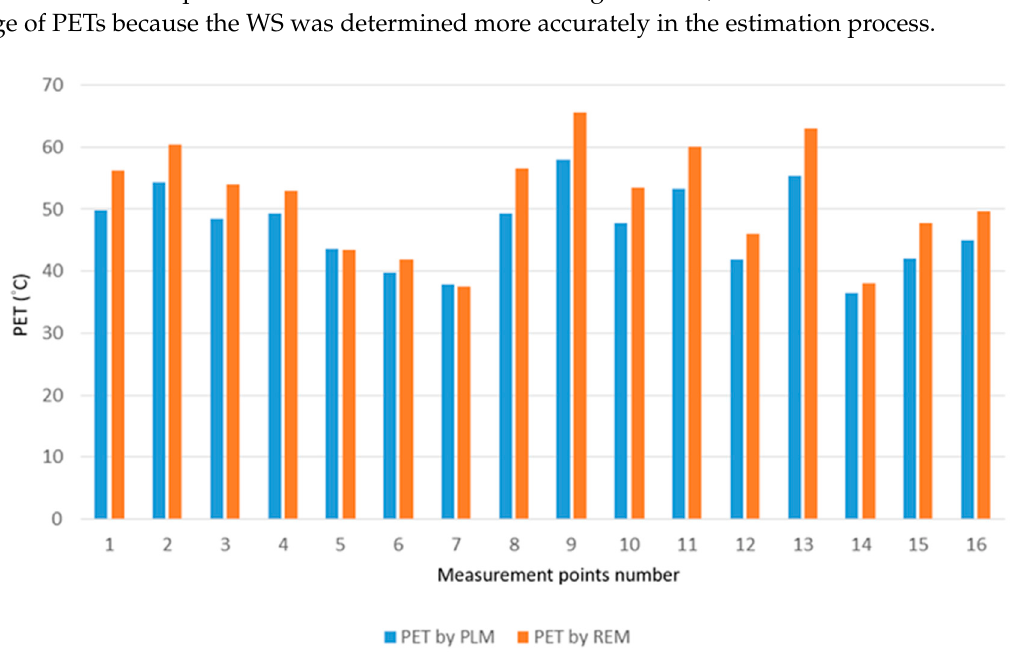
Figure 7. PET difference between PLM and REM.